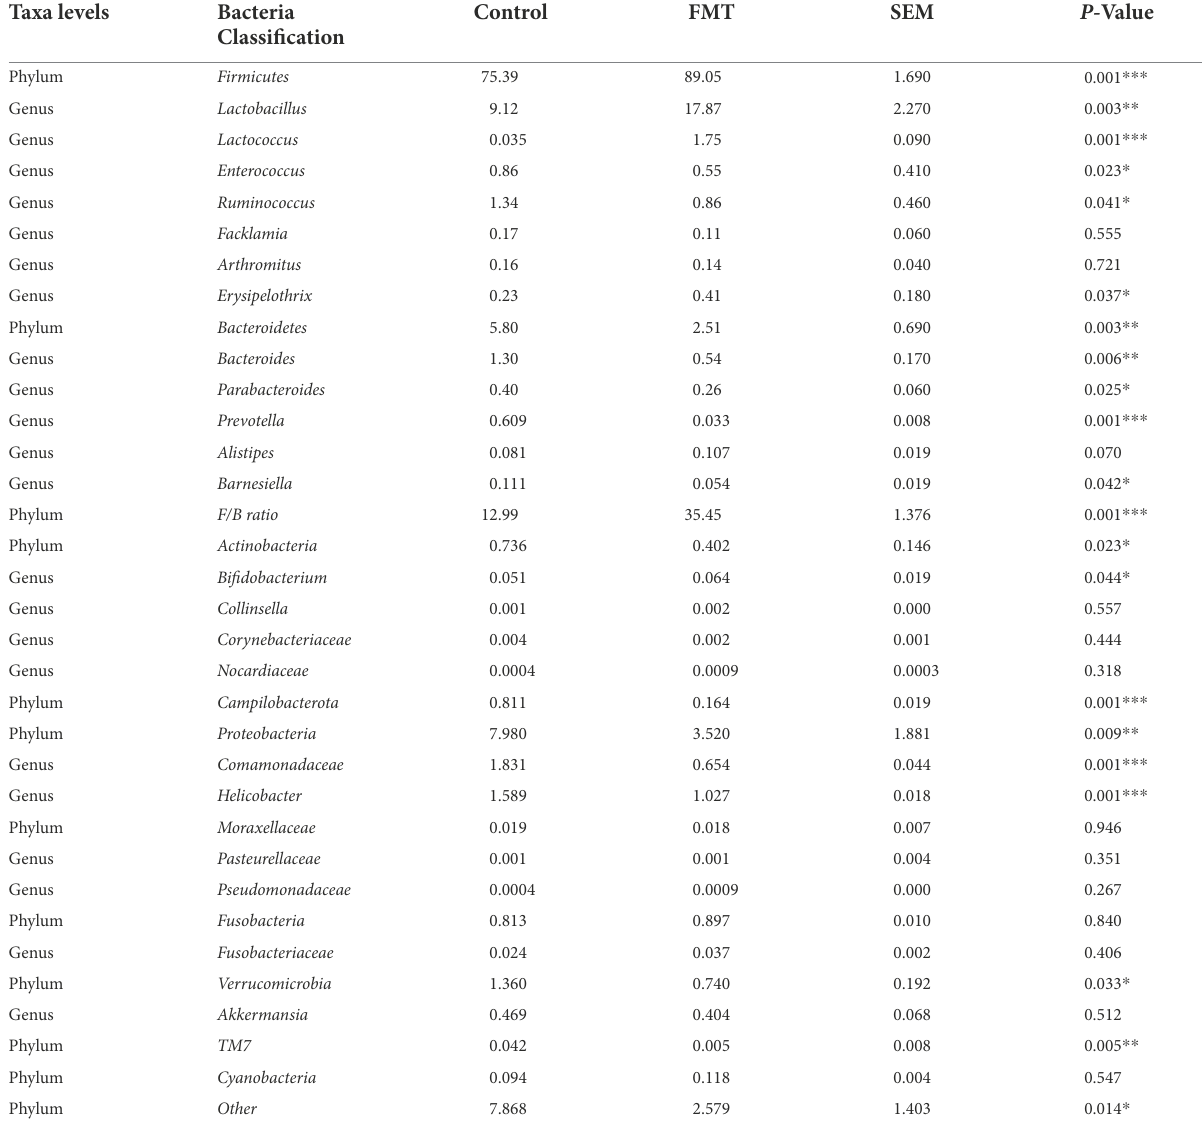
TABLE 4 Relative abundance (percent of total sequences) of taxa in the cecal microbiota of chicks from the control and fecal microbiota transplantation (FMT) groups estimated using metagenomic analysis 1 . Taxa